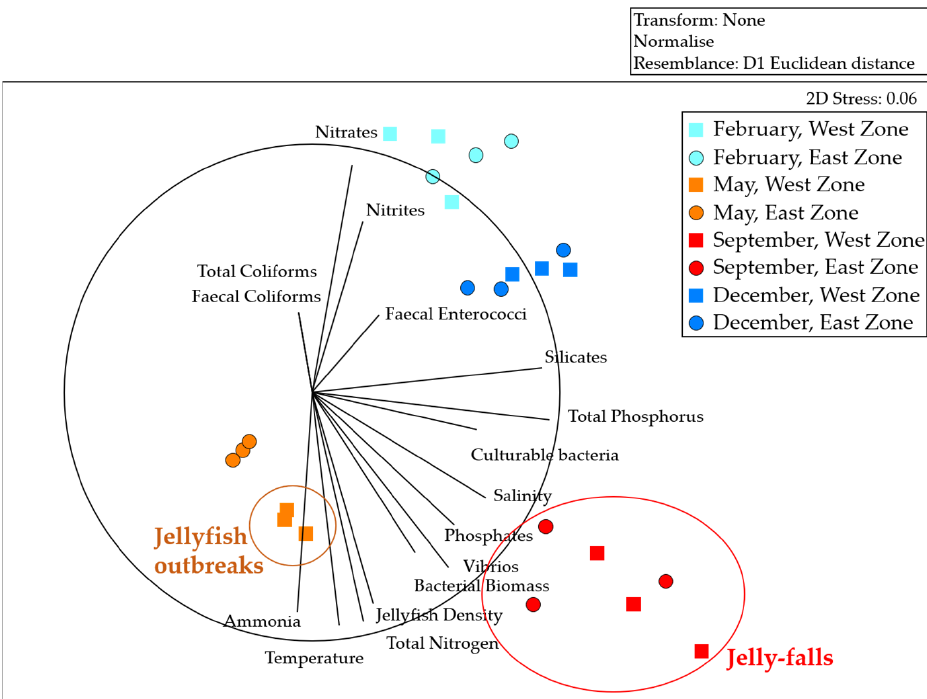
Figure 5. Multidimensional scaling (MDS) plot on Euclidean distances based on normalized data, showing nutrient concentrations in seawater columns along with environmental variables and bacteriological data from the W and E zones during the sampling times. Table 5. Results of the permutational analyses (PERMANOVA) on nutrient composition (ammonia, nitrates, nitrites, total nitrogen, phosphates, total phosphorus, and silicates) in the water columns of W and E zones (Z) among sampling times (T). Abbreviations: Res—residual; Tot—total; df—degrees of freedom; MS—mean squares; Pseudo-F—F critic; P—permutational level of probability. *** p < 0.001; ns—not significant.